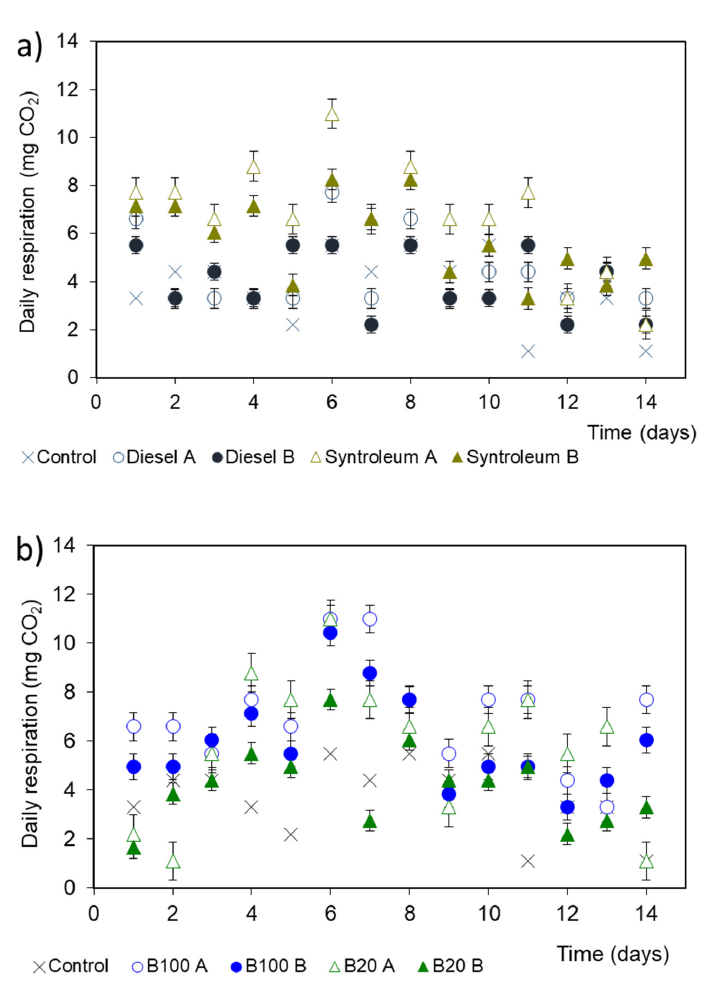
Figure 3. Daily fungal CO 2 production based on volatile compounds for di ff erent fuel types. Conditions: 20 ◦ C; ambient air humidity, 2000 mg of fuel placed without physical contact with soil or the investigated fungi. Symbol A represents experimental setups with ~1 g of soil, and symbol B without any soil. ( a ) Control, conventional diesel and Syntroleum; ( b ) control, fish biodiesel (B100) and fish biodiesel blend (B20). Values represent means ± standard error. Microorganisms 2020 , 8 , x FOR PEER REVIEW